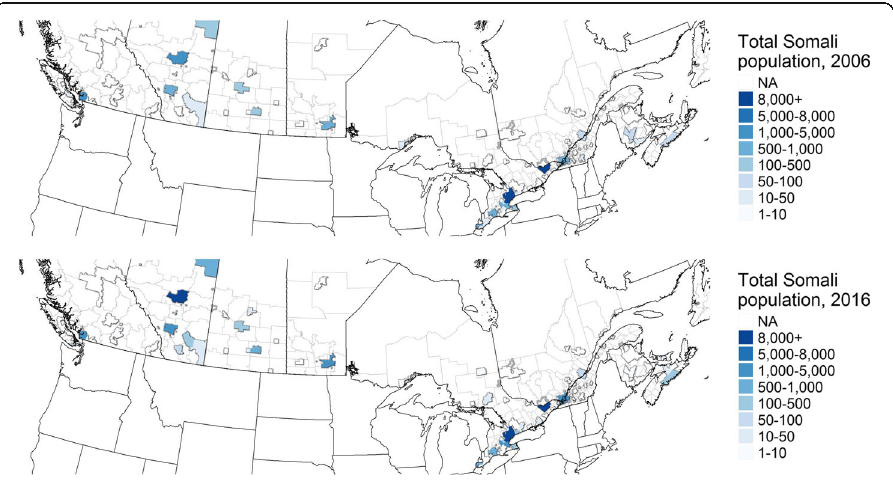
Fig. 4 Somali populations in Canada's Census Metropolitan Areas (CMAs), 2006 and